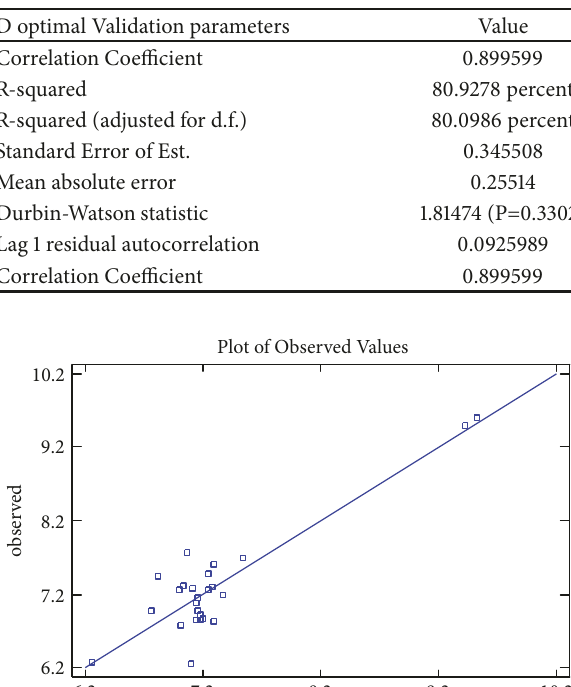
Table 8: D optimal validation parameters.